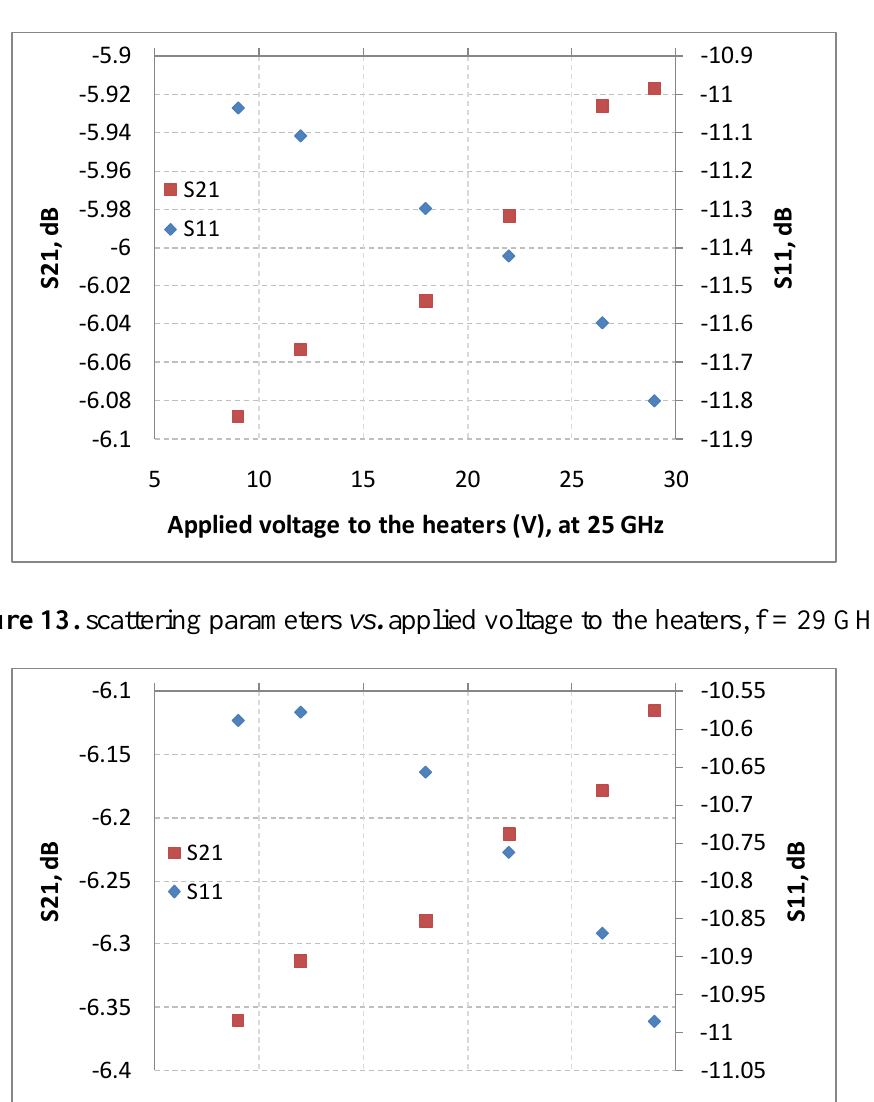
Figure 12. scattering parameters vs. applied voltage to the heaters, f = 25 GHz.